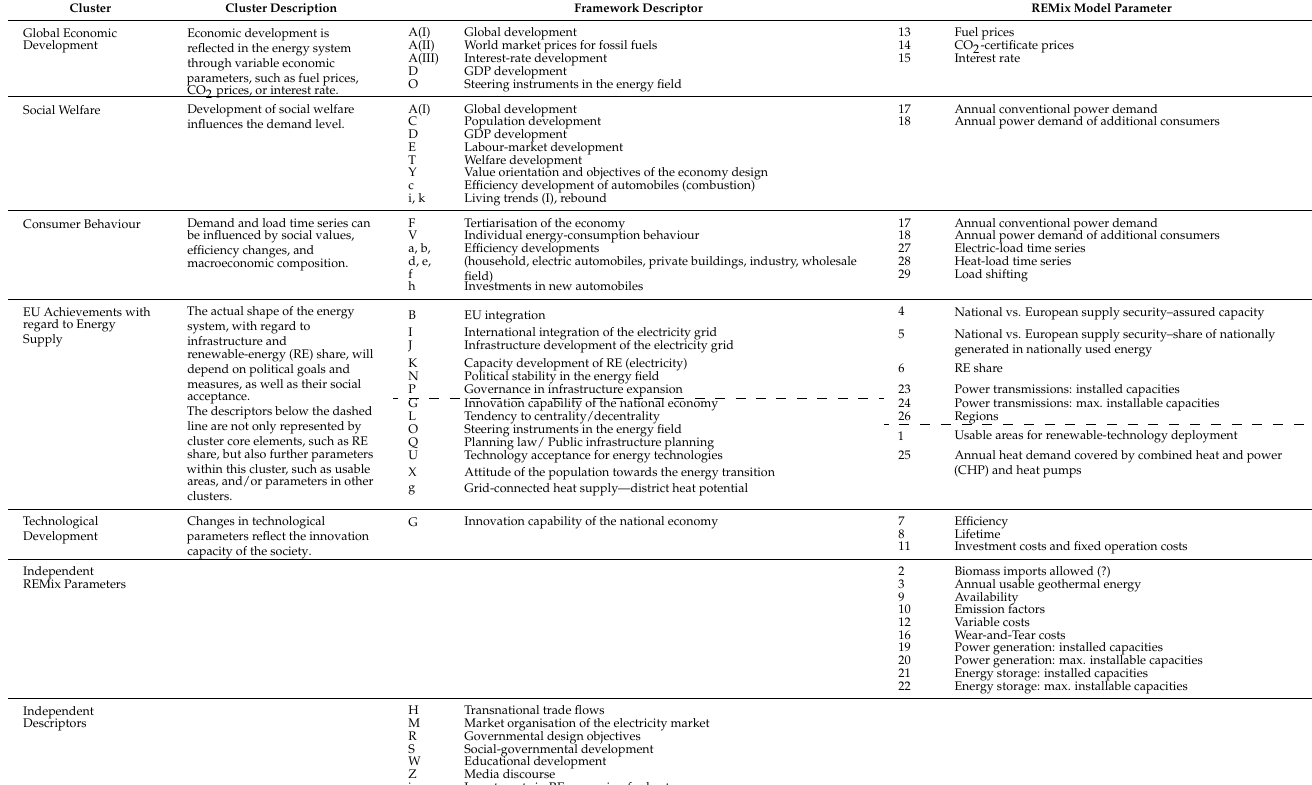
Table 2. Clusters of REMix model parameters influenced by similar framework